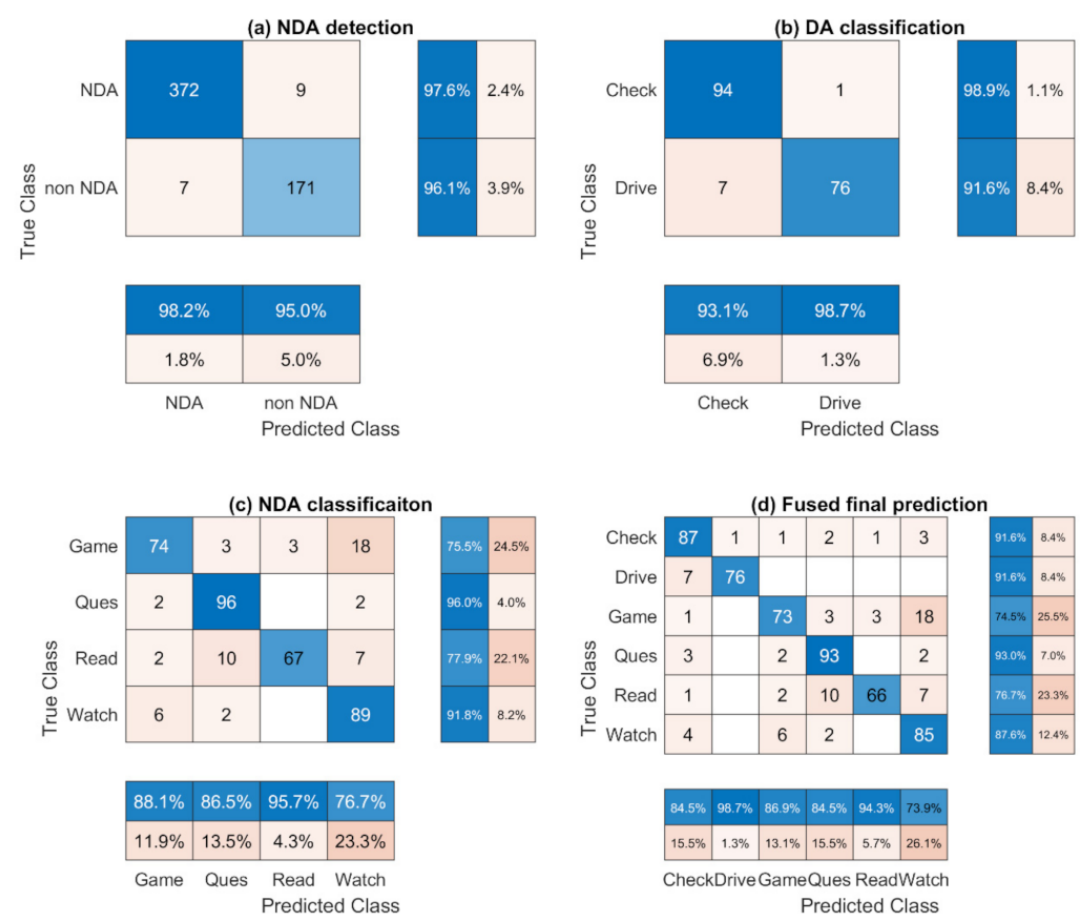
Figure 8. Confusion matrices of the 3 developed 3D CNN models and the fused results. The precision and recall for each class are presented in the bottom and right of the figure, respectively. Table 2. Road-checking behaviour